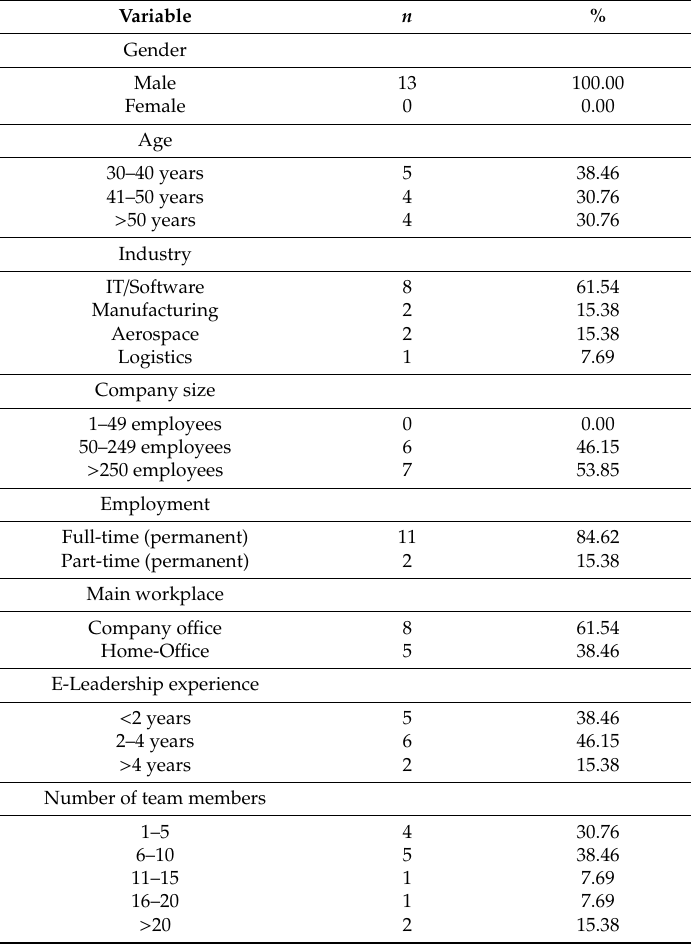
Table 2. Participants’ characteristics ( n =